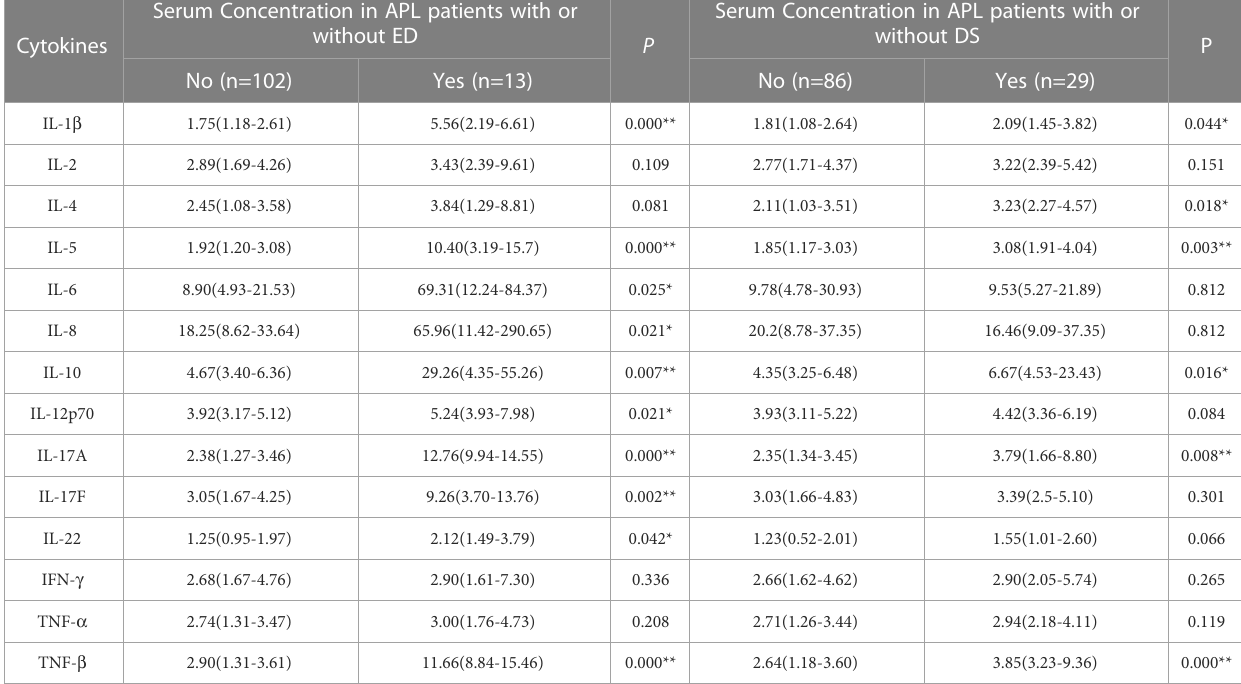
TABLE 5 Effects of cytokine levels on early death (ED) and differentiation syndrome (DS) in newly diagnosed APL patients (pg/ml, M[IQR] ). Serum Concentration in APL patients with or Serum Concentration in APL patients with or without ED P without DS Cytokines